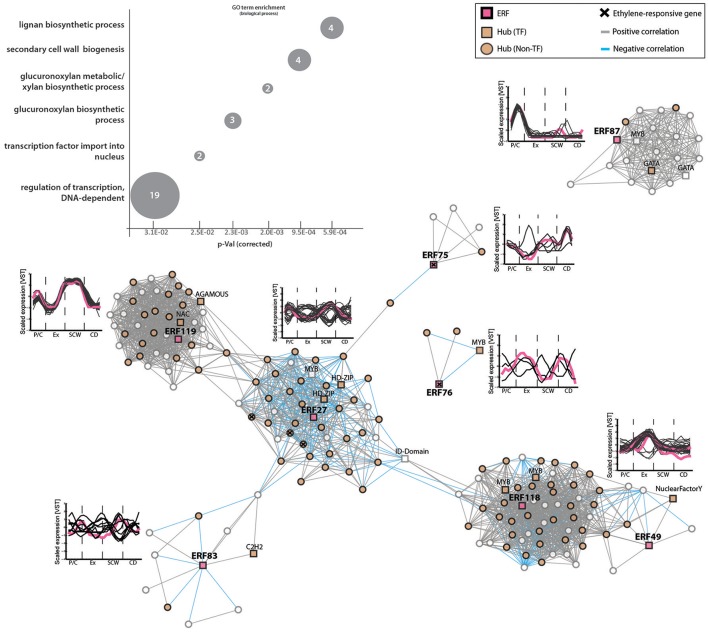
ERF gene modules are associated mainly with pectin, lignan and xylan biogenesis during secondary growth. Co-expression gene modules of ERF27, ERF75, ERF76, ERF83, ERF87, ERF118, ERF119 (threshold of five). TFs are shown in squares, while all non-TFs are represented by circles. Hubs are indicated in orange. Positive correlation between two genes is represented by gray lines (edges), negative correlations are indicated by blue edges. Ethylene-responsive genes (shown in Figure 2C) inside each gene module are marked with a cross (see Supplementary Table S6). Line graphs show expression profiles (scaled) of genes in each module during wood development. Pink lines mark ERFs inside each gene module. GO term enrichment was performed with A. thaliana homologs (Supplementary Table S6). The numbers indicate number of genes belonging to this GO term found among all 143 ERF co-expressed genes.